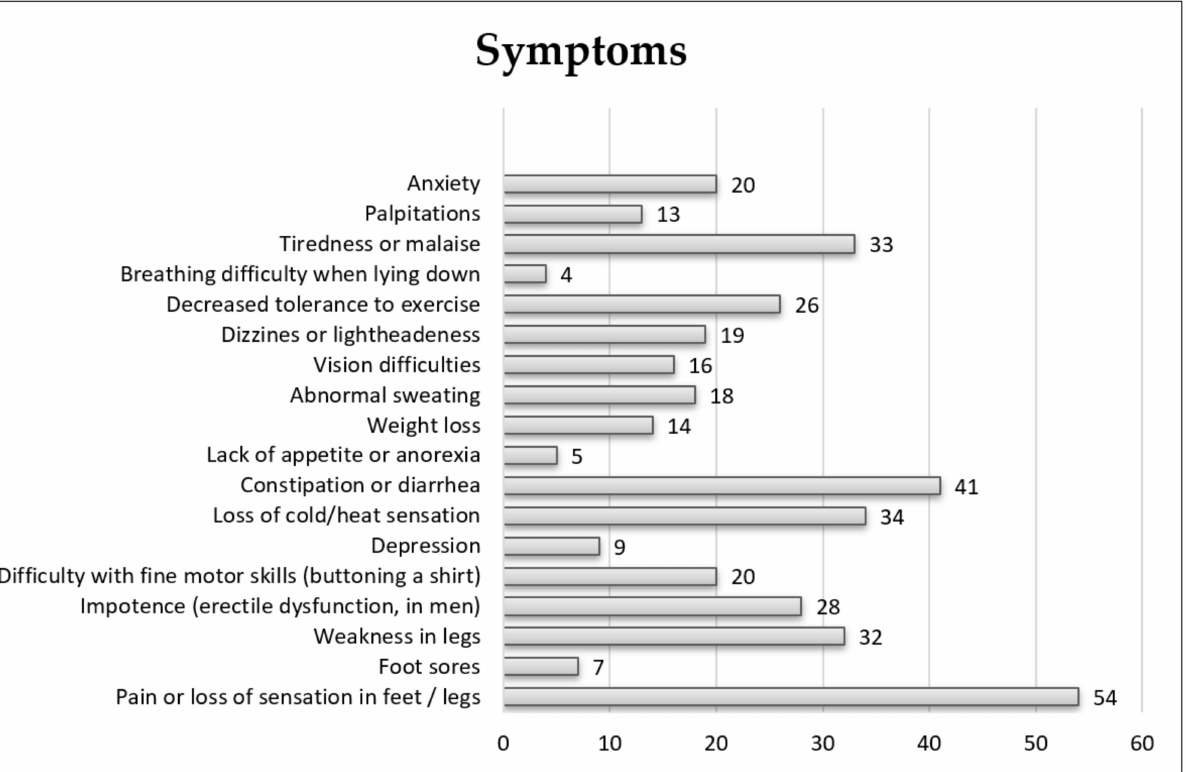
Figure 1. Global study population symptoms reported in the